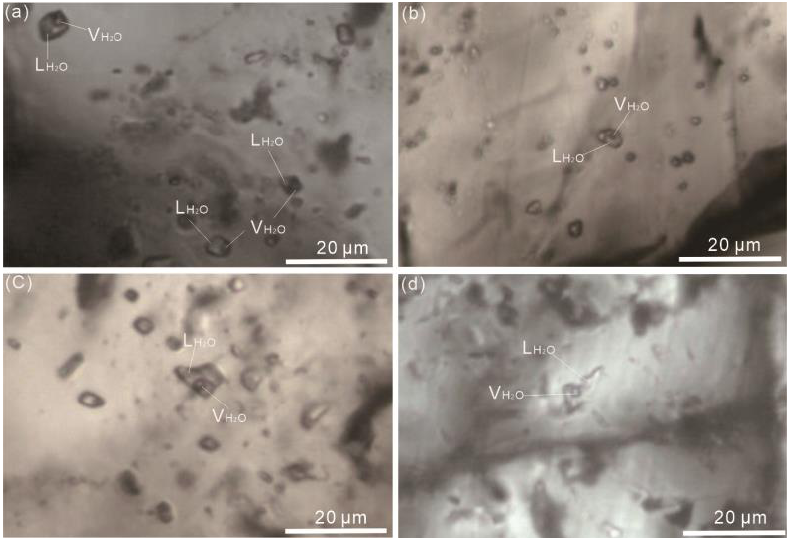
Figure 4. Photomicrographs showing the types and distribution of fluid inclusions in quartz from the Baiyangping Cu – Co – Pb – Zn deposit. ( a – c ) Liquid-rich two-phase inclusions in quartz; ( d ) liquid-rich two-phase inclusions in calcite.